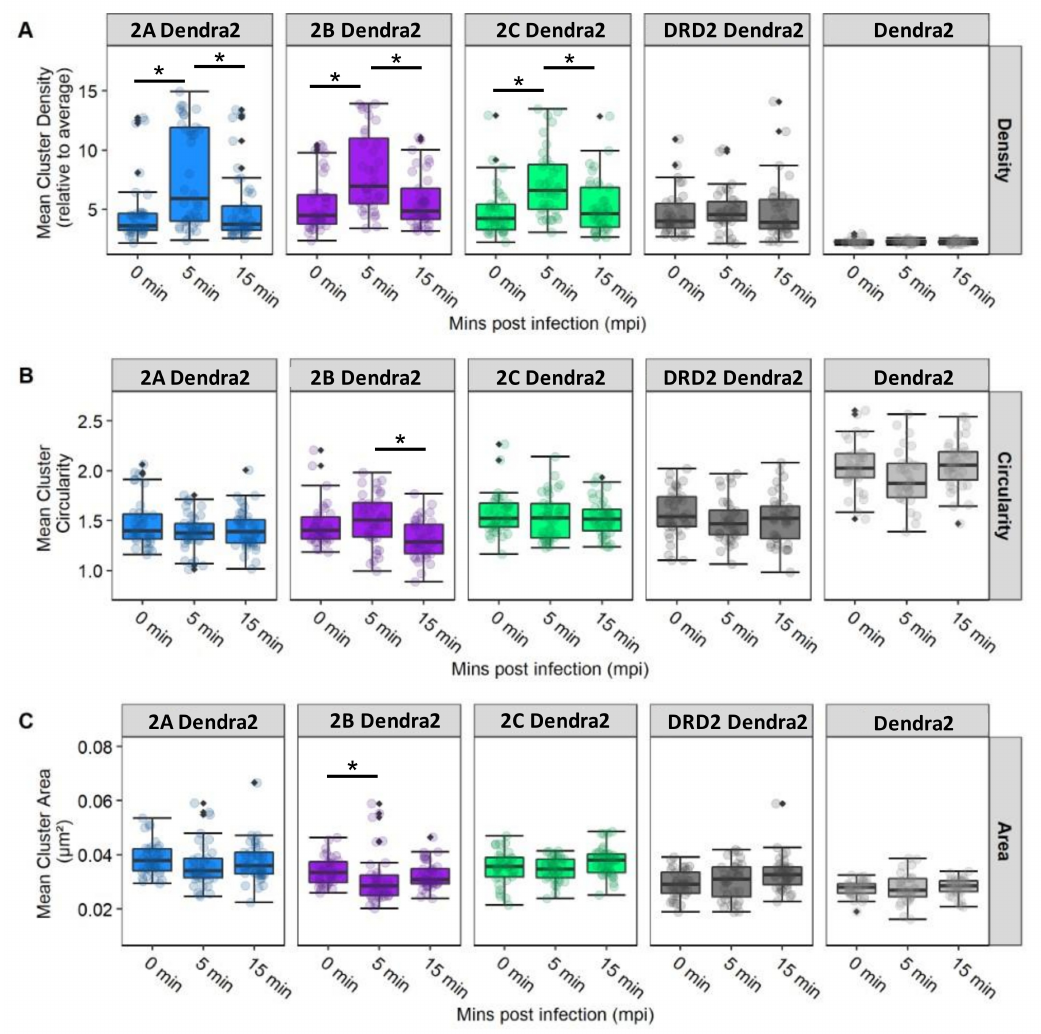
Figure 6. 5-HT 2 R cluster properties for receptors subtypes in infected cells. Cluster properties including ( A ) mean cluster density, ( B ) circularity, and ( C ) area were calculated for localizations